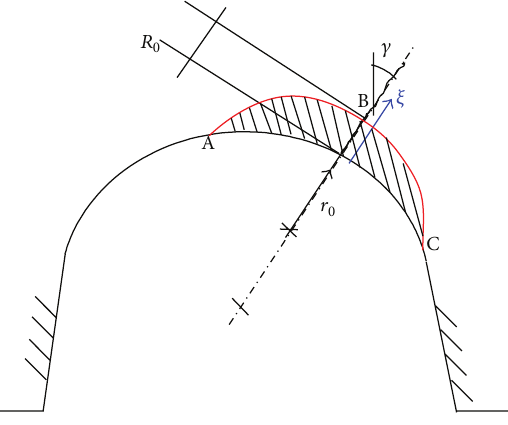
Figure 7: V-notch under mixed mode